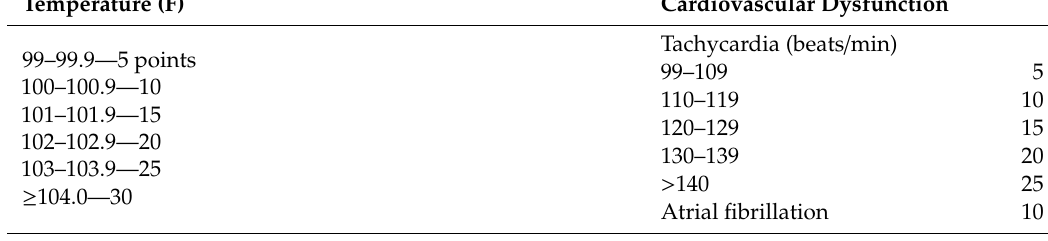
Table 3. Burch-Wartofsky Point Scale [14].